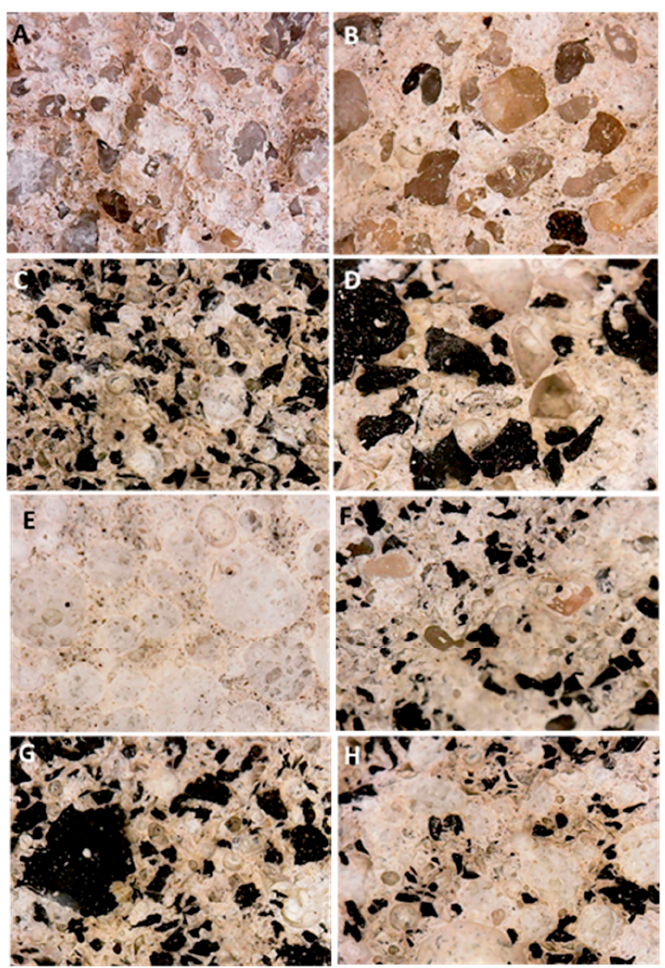
Figure 6. Sections of the specimens after the mechanical tests. ( A ) Norm (sample 1), ( B ) Sand (sample 2), ( C ) TR f (sample 3), ( D ) TR c (sample 4), ( E ) PG (sample 5), ( F ) TR f / Sand (sample 6), ( G ) TR f / TR c (sample 7), ( H ) TR f / PG (sample